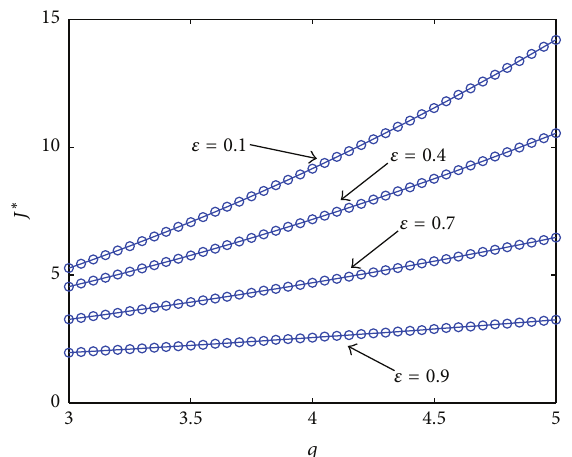
Figure 3: 𝐽 ∗ with respect to 𝑞 for different 𝜀 ( 𝑝 = −2 , Φ = 0.2 , Π = 0.6 , and Λ = 0.6